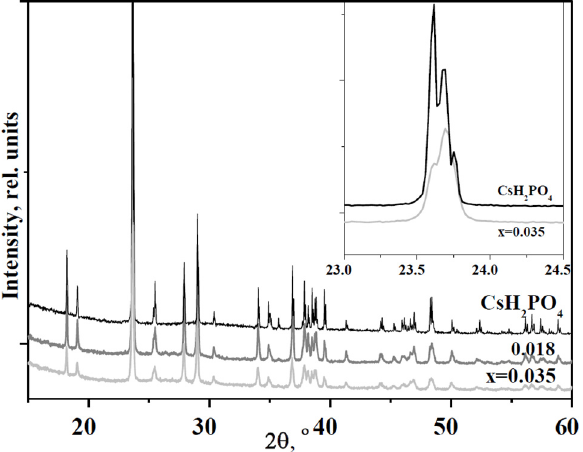
Figure 5. PXRD patterns of (1 − x)CsH 2 PO 4 -xUiO-66 in comparison with CsH 2 PO 4 . The inset shows the 011 and − 111 reflexes.